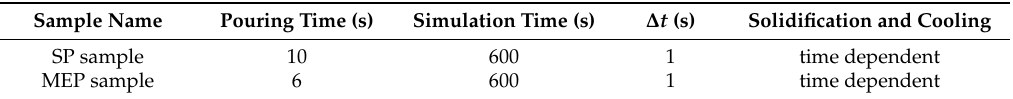
Table A5. Solidification conditions in the numerical